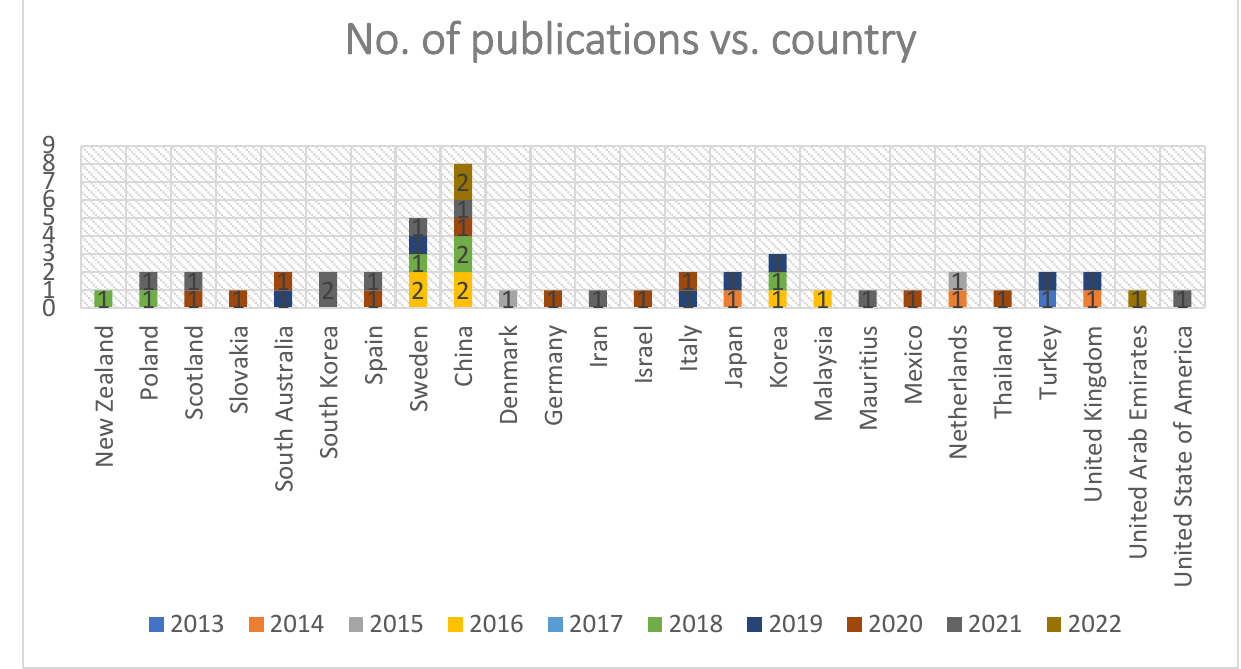
Figure 4. The n umber of publications vs. country. Figure 4. The number of publications vs. country.